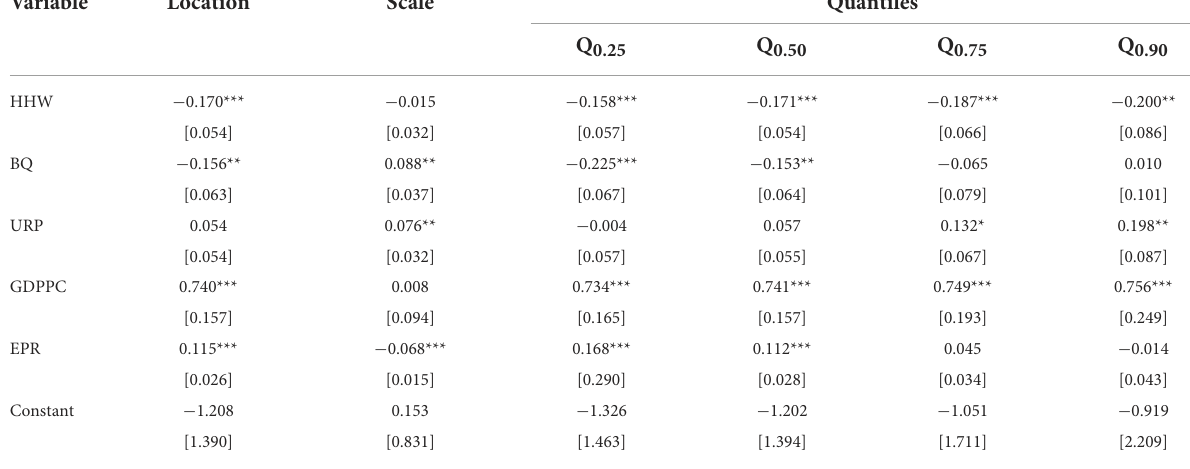
TABLE 6 Estimates of quantile regression–MMQR